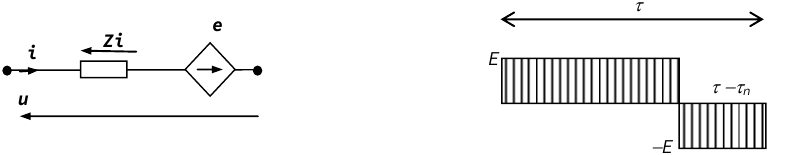
Figure 4. Diagram of a voltage-controlled branch and a sampled voltage waveform of e ( t ) within period τ .